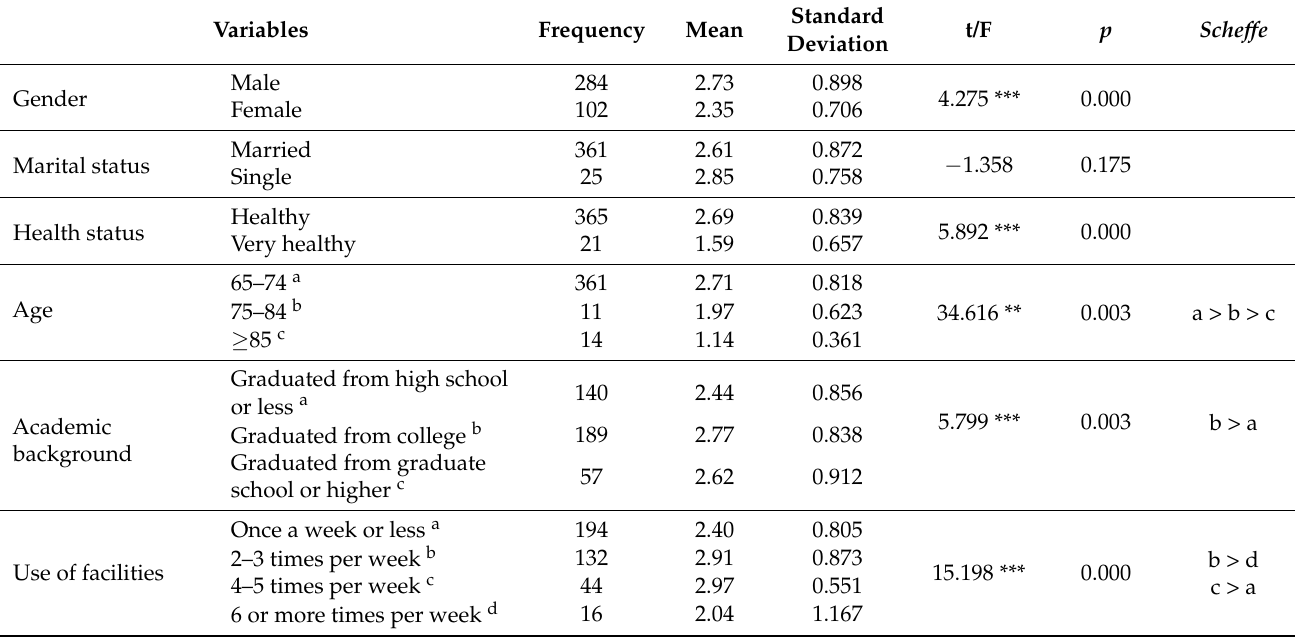
Table 5. Differences in humanistic service factors according to demographic